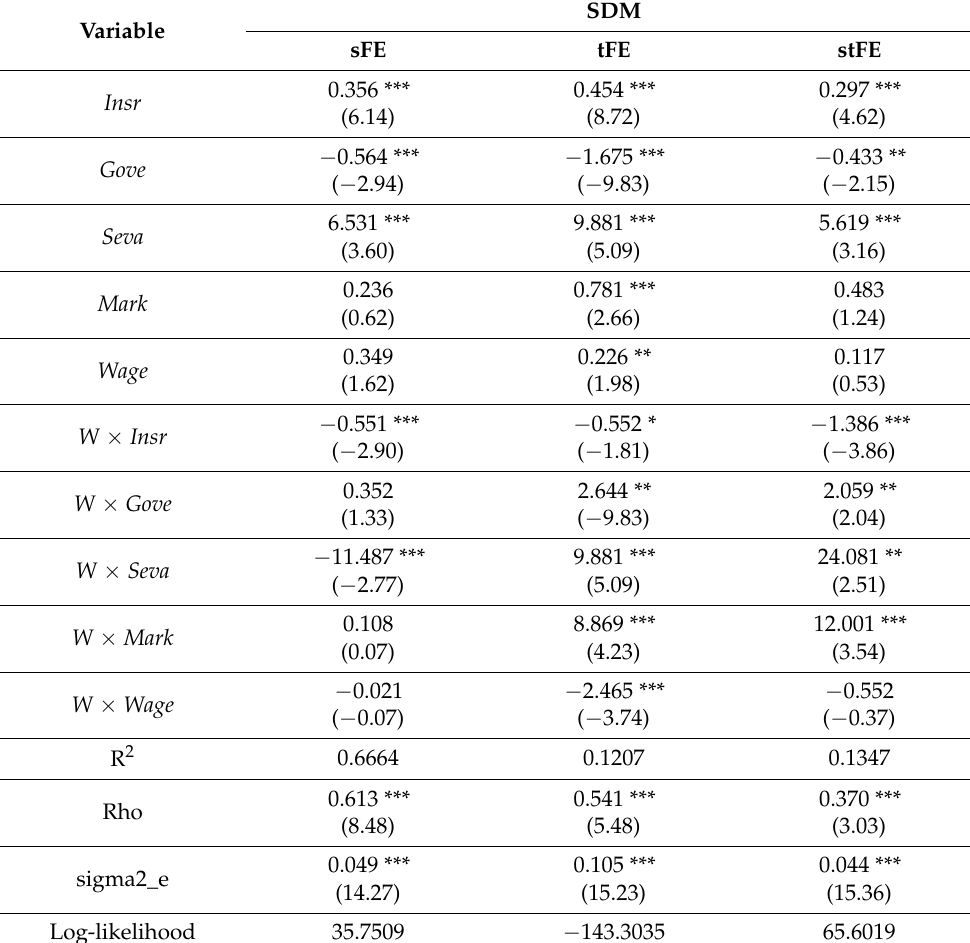
Table 3. Spatial model estimation